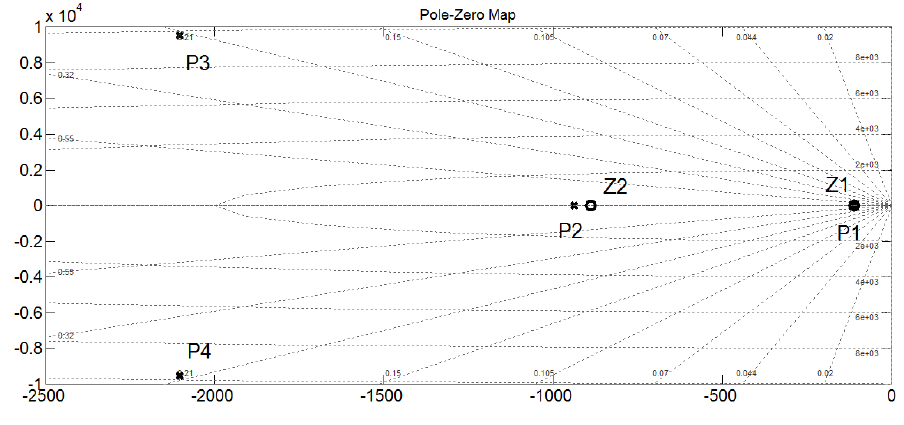
Figure 11. Zero-pole distributive chart of the closed-loop transfer function 𝐺